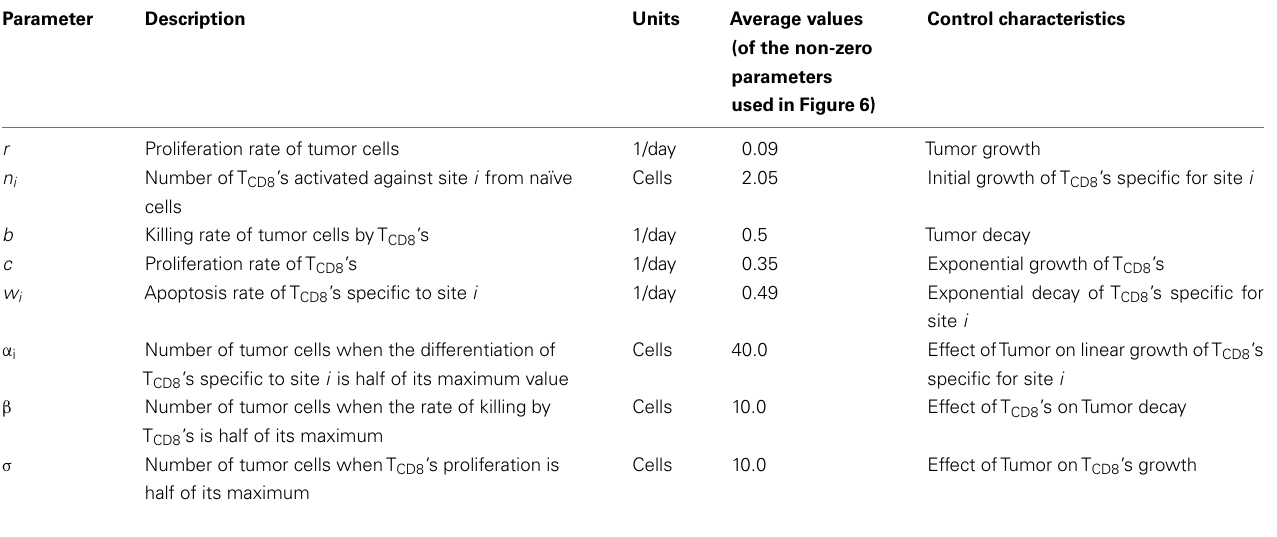
Table 1 | Model parameters and